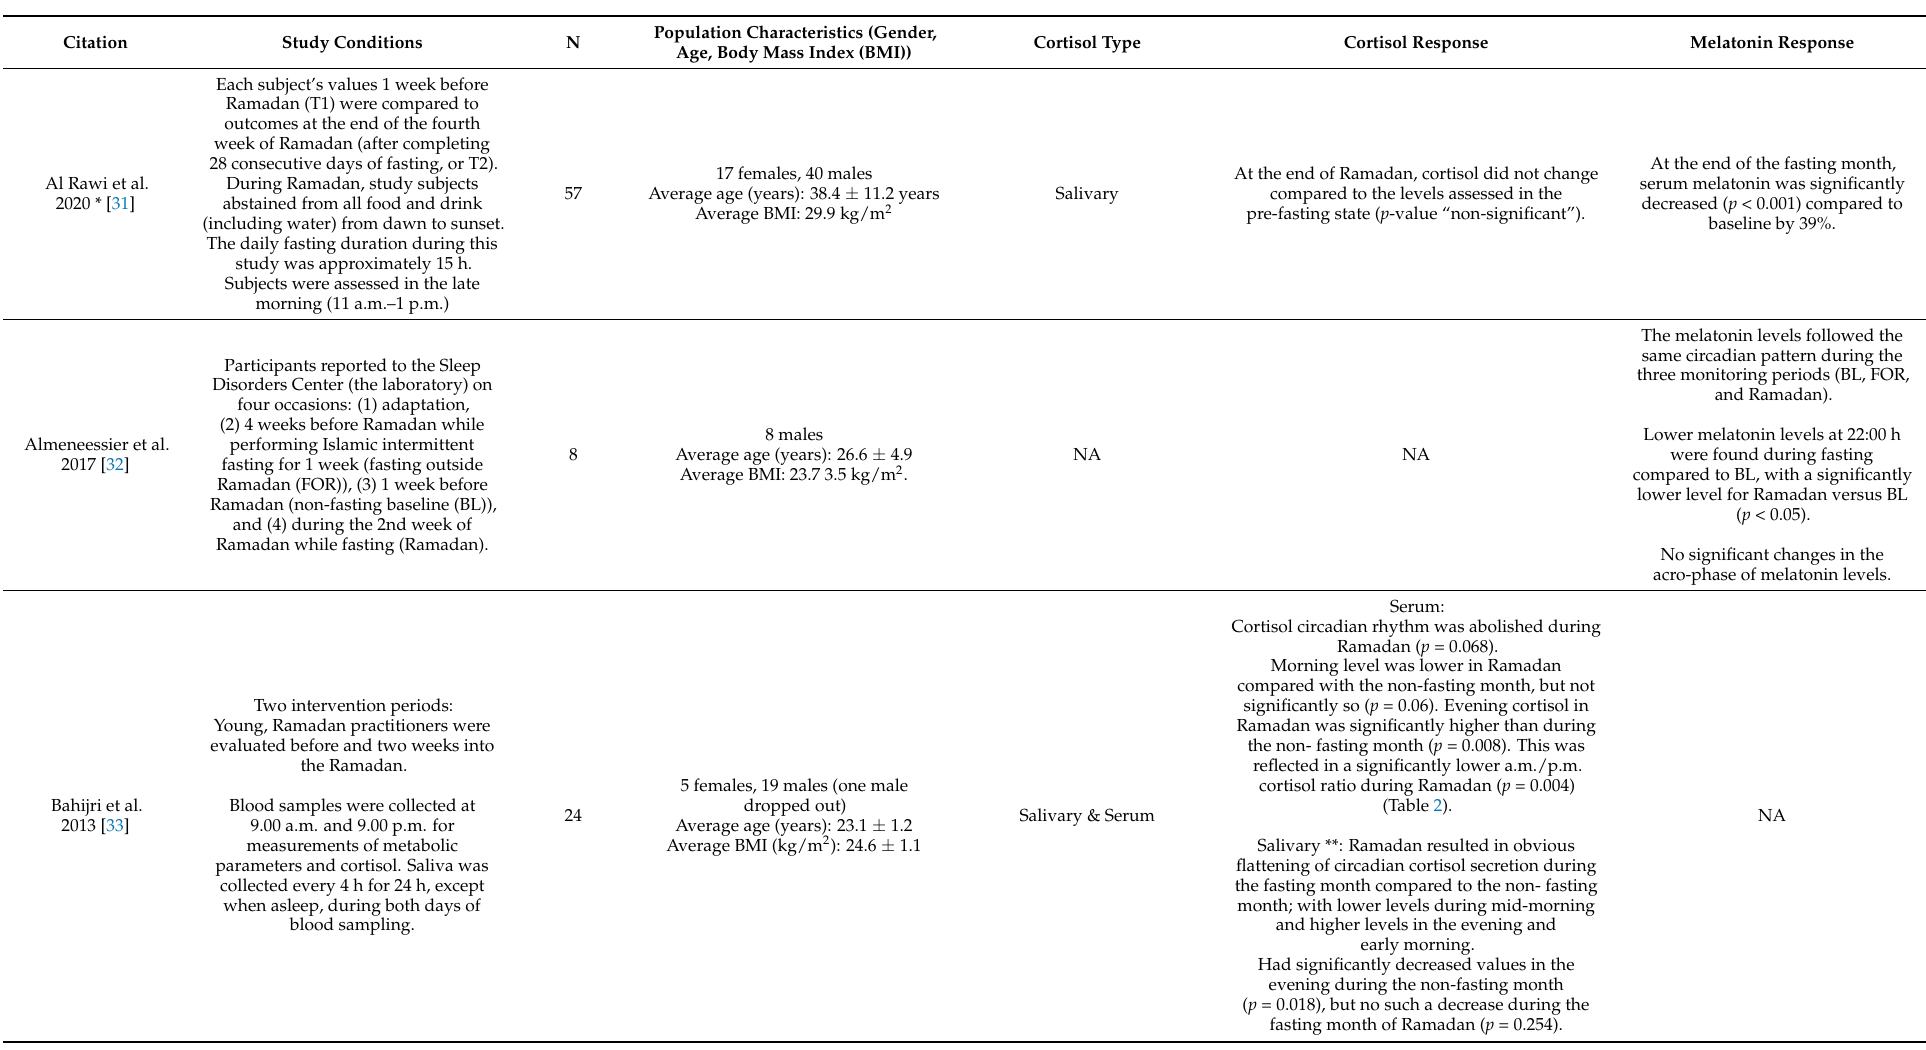
Table 1. Study Characteristics of Included Papers on